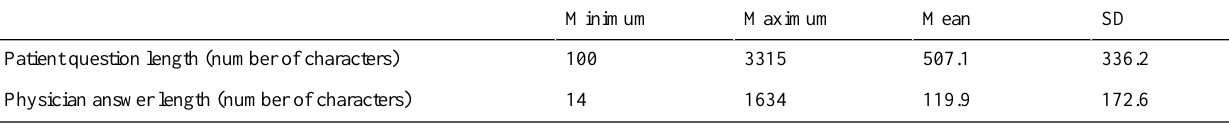
SDMeanMaximumMinimum